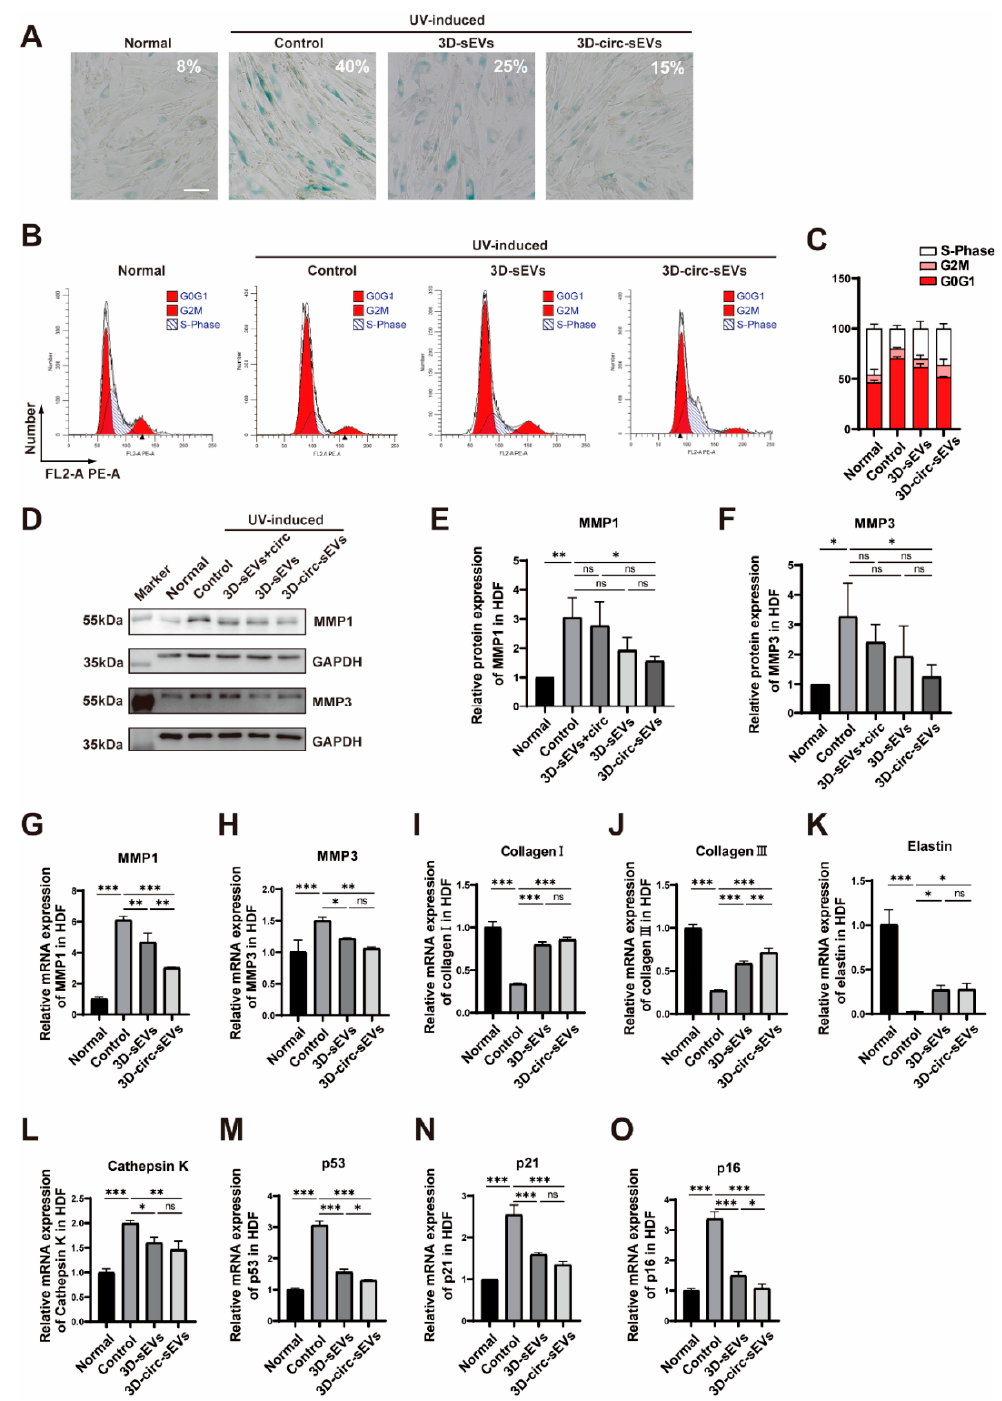
Figure 4. 3D-circ-sEVs have a slight preventive effect on photoaging in vitro. ( A ) HDF cells were stained with a β -galactosidase staining kit. Blue color indicates senescent cells. Scale bars = 200 µ M. ( B ) The cell cycle was analyzed in control group or treated group using flow cytometry on day 7. ( C ) Quantitative analysis of the effect of 3D-circ-sEVs on the cell cycle arrest alleviation (n = 3). ( D ) Representative blotting image of MMP1 and MMP3 in UVA-irradiated HDF cells after being treated by different sEVs. ( E,F ) Quantitative analysis of the effect of 3D-circ-sEVs on the protein expression